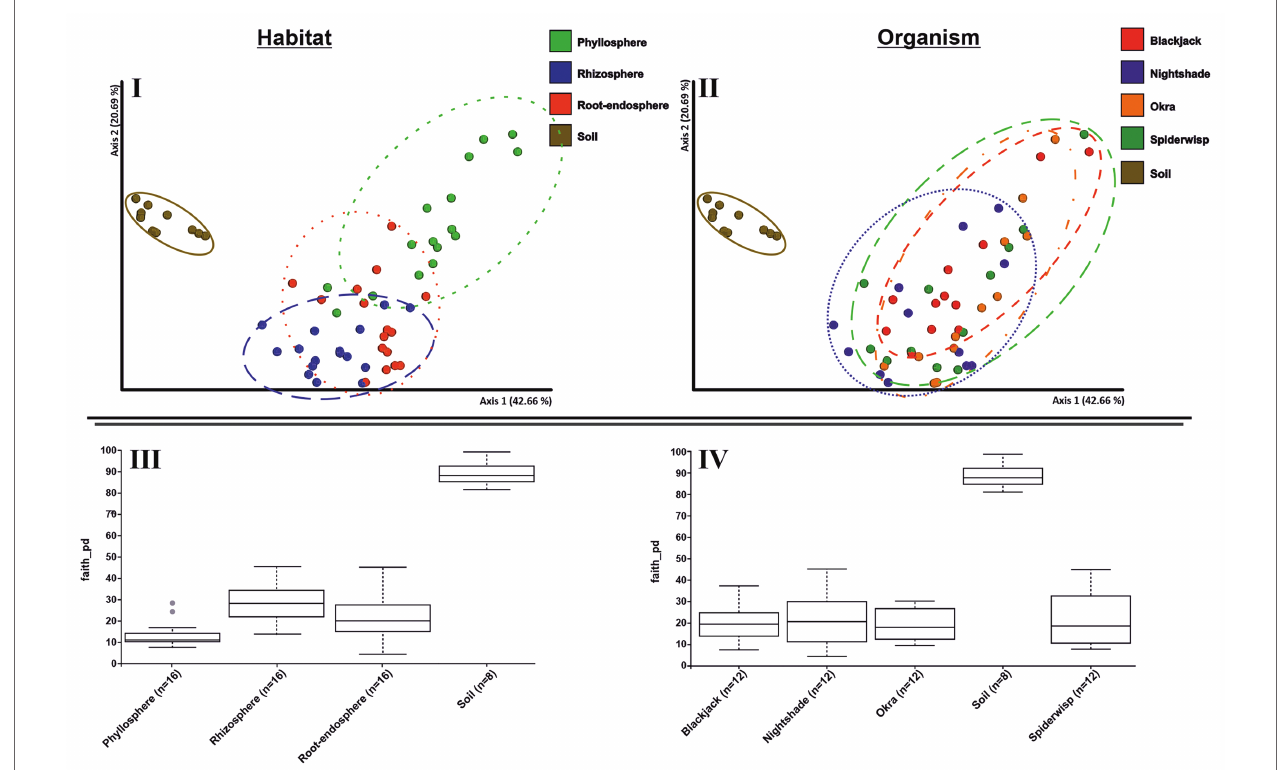
FIGURE 3 | Bacterial alpha and beta diversity of leafy green vegetables. Principal coordinate analysis (PCoA) plots of the 16S rRNA amplicon datasets of four crops (blackjack, nightshade, okra, and spiderwisp) constructed based on phylogenetic distance metrics (weighted UniFrac). The distance between the data points negatively correlates with the similarity of the communities. (I) Clusters of the communities based on microhabitat (phyllosphere, rhizosphere, root-endosphere, and soil), and (II) based on plant species (blackjack, nightshade, okra, spiderwisp, and soil). Comparison of bacterial alpha diversity based on Faith’s phylogenetic diversity of the microhabitats (III) and plant species (IV)